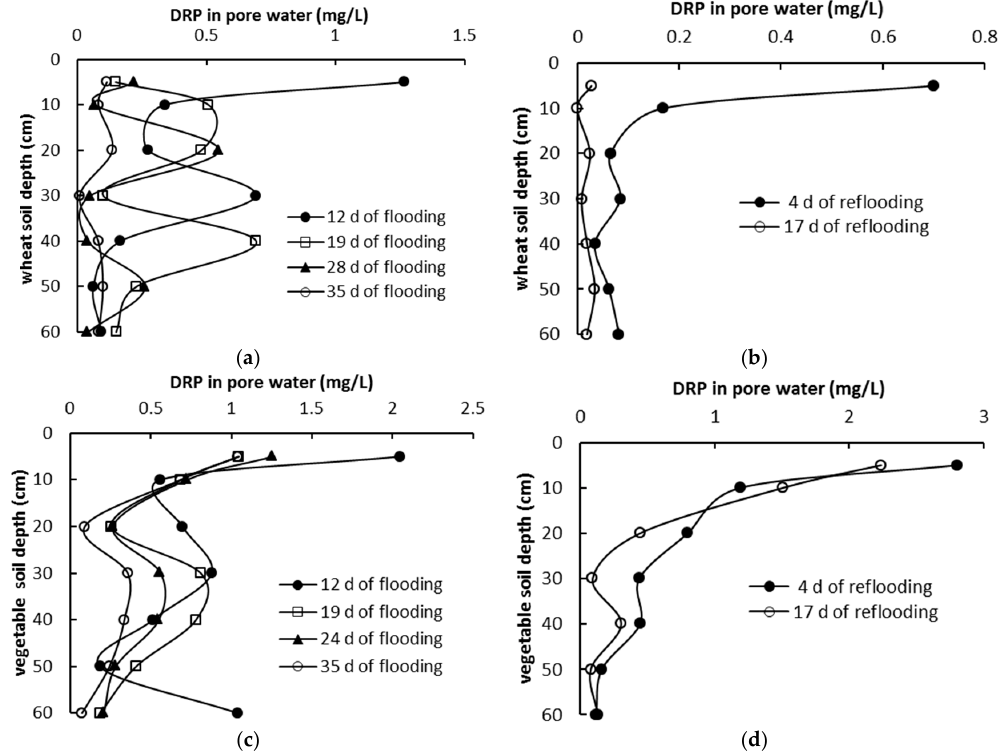
Figure 4. Pore water DRP in different soil layers (( a ) WS, flooding; ( b ) WS, reflooding; ( c ) VS, flooding; ( d ) VS, reflooding).